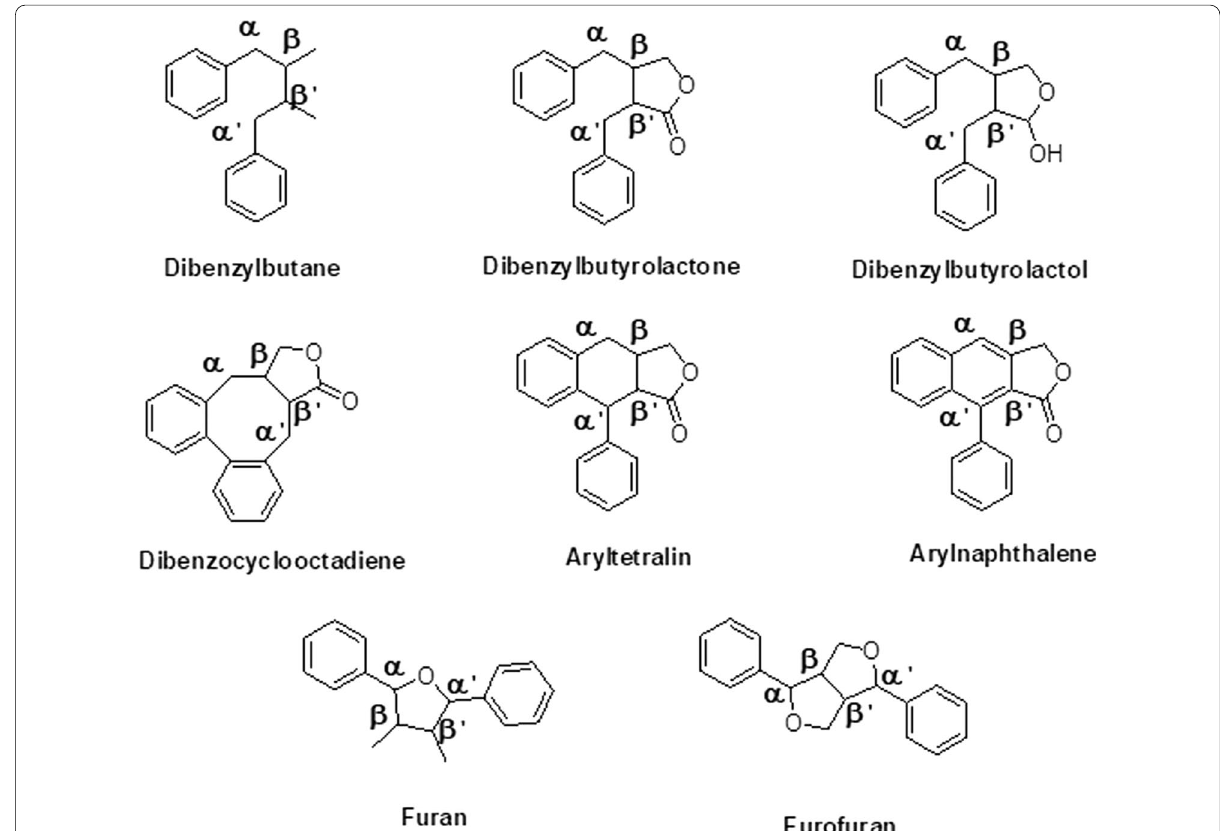
Fig. 3 Eight chemical classes of lignan